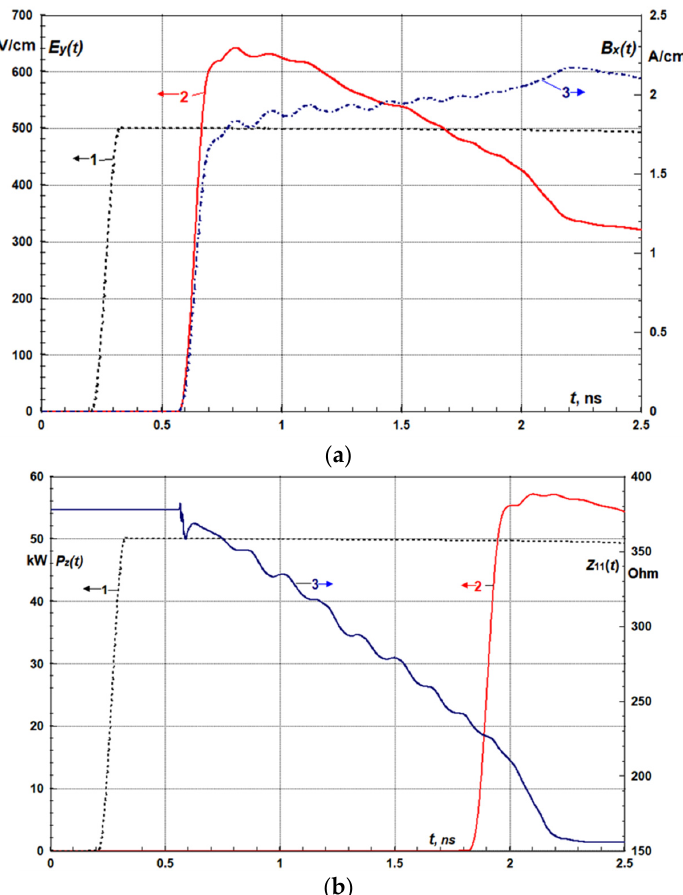
Figure 6. Time-dependent parameters of calculation. ( a ) 1 = external E y ( t ; z = 6 cm); 2 = E y ( t ; R 2 ) inside the antenna at point R 2 ( x = 14 cm, y = 3 cm, z = 17 cm); 3 = magnetic field B x ( t ; R 2 ). ( b ) 1 = external power flow P a 2 , in ( t ) throughout the antenna aperture of A a 2 ; 2 = received power P a2 ,rec (t ; z = 53 cm); 3 = local impedance at the point R 2